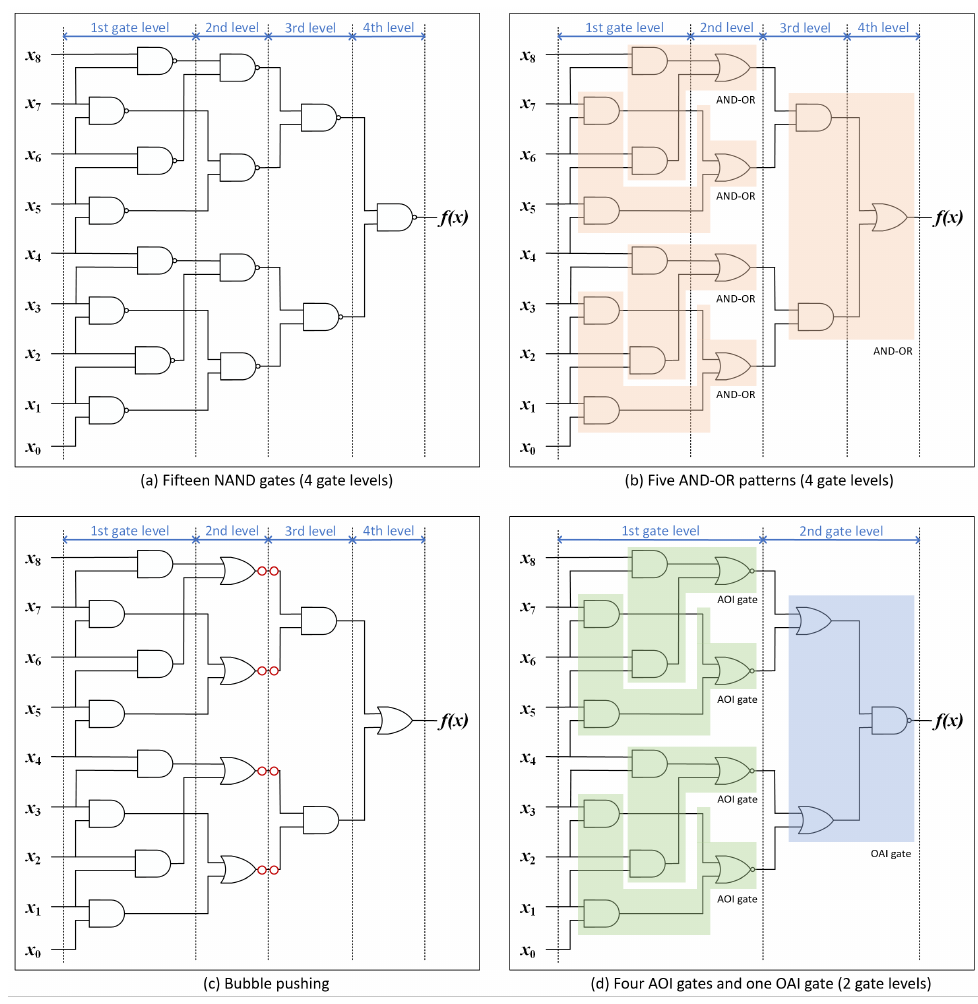
Figure 5. A low-latency implementation of F 0 .